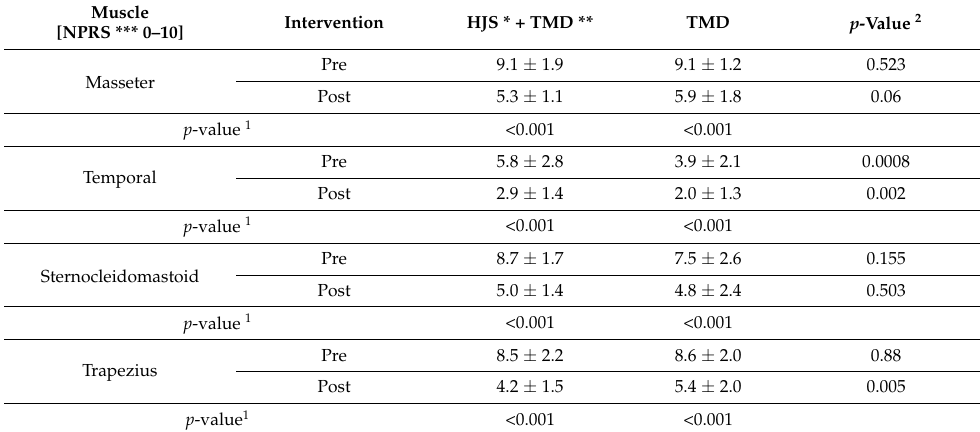
Table 5. Changes in the myofascial pain at pre- and post-intervention ( n =